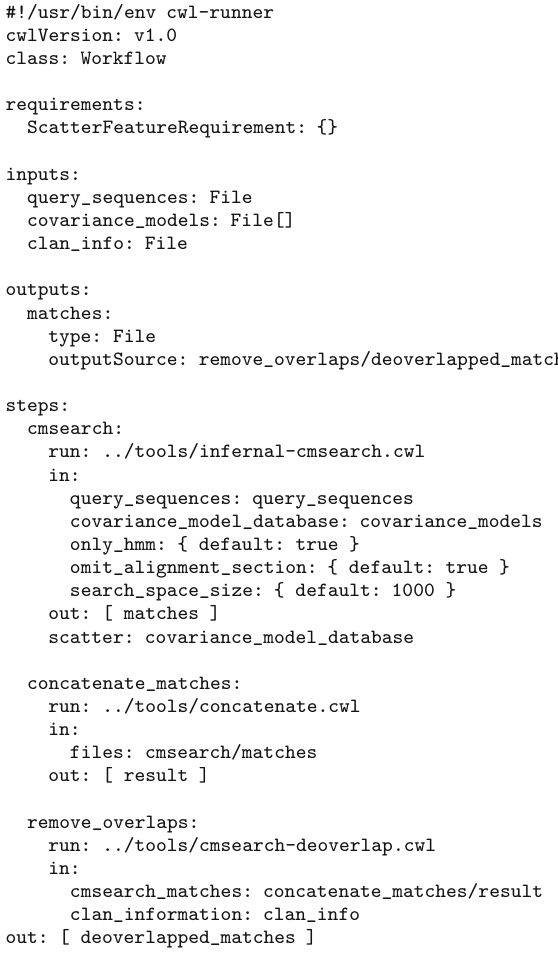
Table 4 Example CWL workflow from EBI Metagenomics using the tool infernal as described in Table 3 File workflows/cmsearch-multimodel.cwl: #!/usr/bin/env cwl-runner cwlVersion: